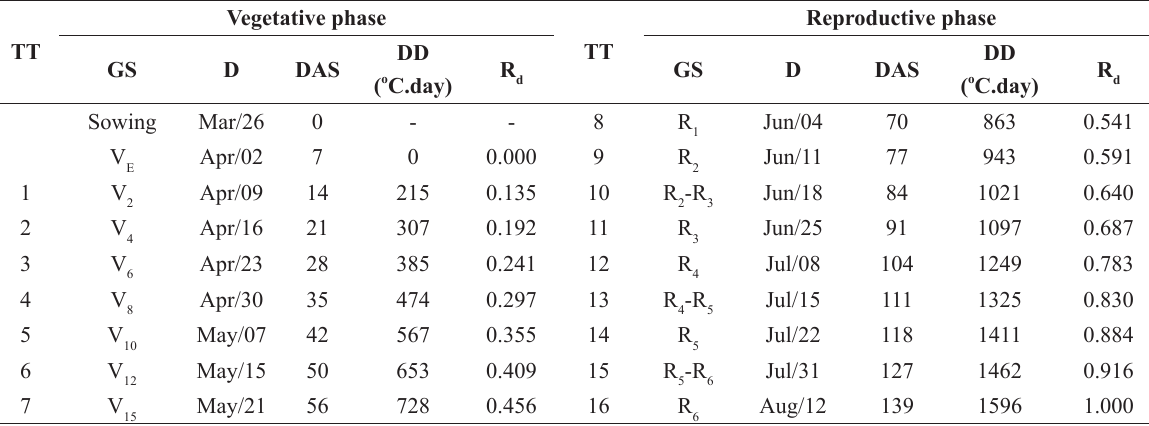
Description of treatments (tt) each referring to a sampling date, growth stages (Gs) of the maize crop (hybrid DKb 390 pro 2), and respective calendar dates (D), days after sowing (Das), accumulated degree-days (DD, o c.day), and relative development (r ) based on DD. piracicaba (sp), brazil. d